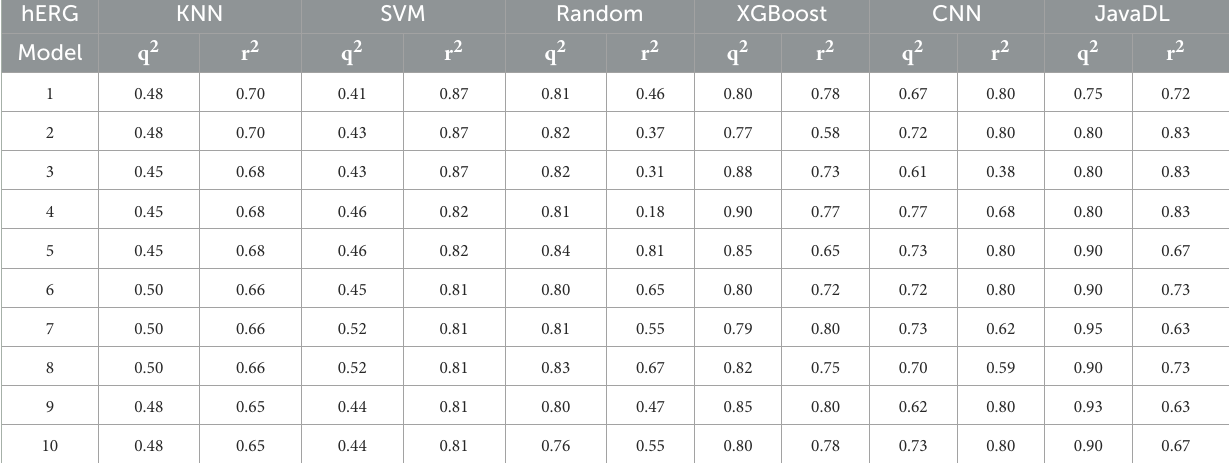
TABLE 2 Method comparison with the hERG dataset.